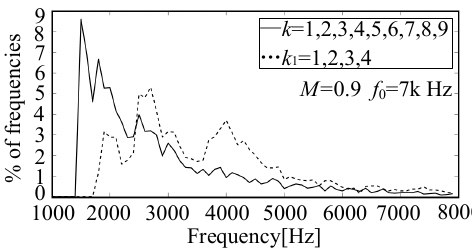
Figure 10. Distribution of switching frequencies by using the set numbers of k and k 1.